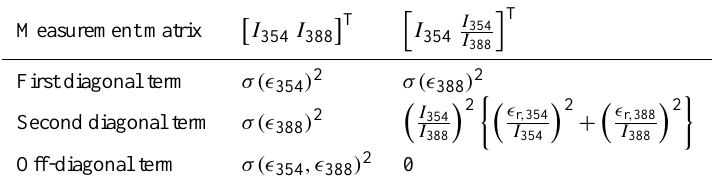
Table 4. Diagonal and off-diagonal elements of the measurement error covariance matrices using two different measurement matrices. Measurement